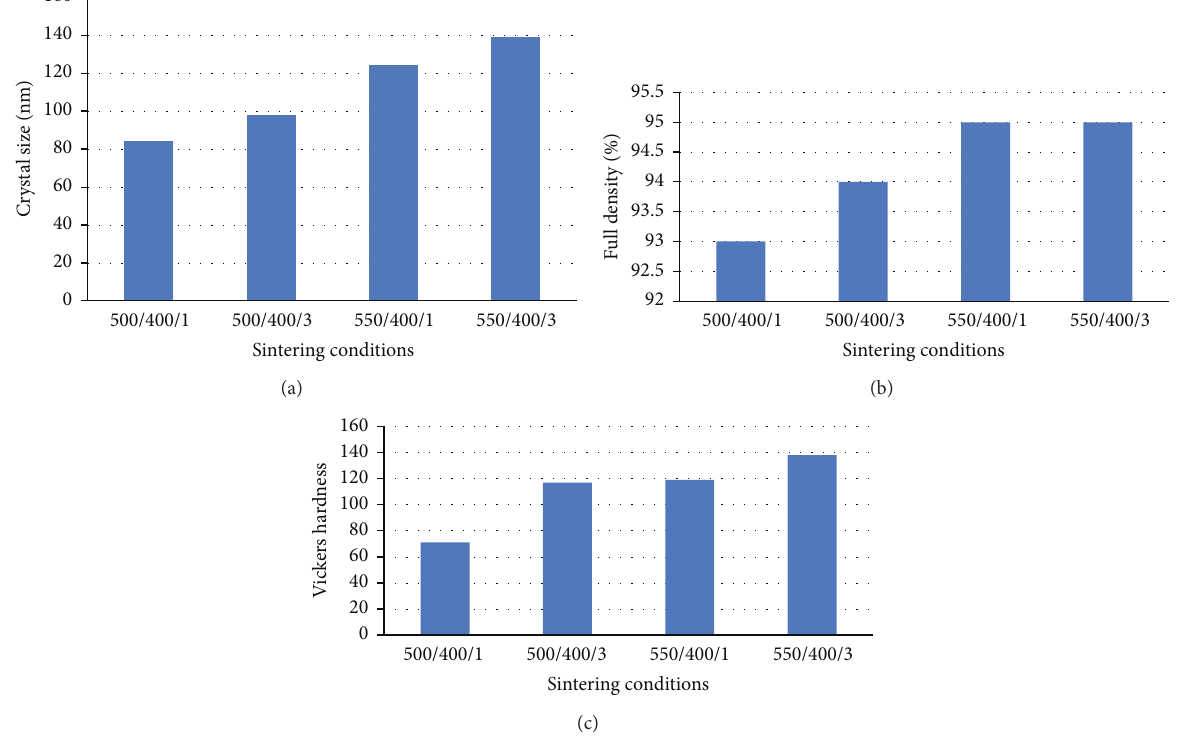
Figure 7: Effect of different sintering conditions (sintering temp. ( ∘ C)/heating rate ( ∘ C/min)/sintering time (minutes)) on crystal size in (a) percentage of full density in (b) and Vickers hardness in (c) for the powders cryomilled for 7